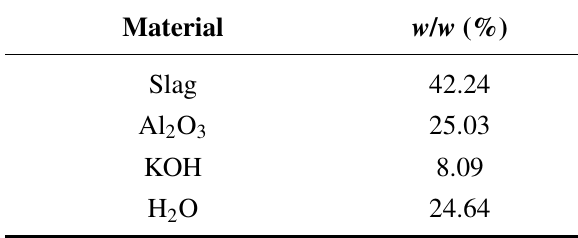
Table 2. Synthesis of the K-geopolymer